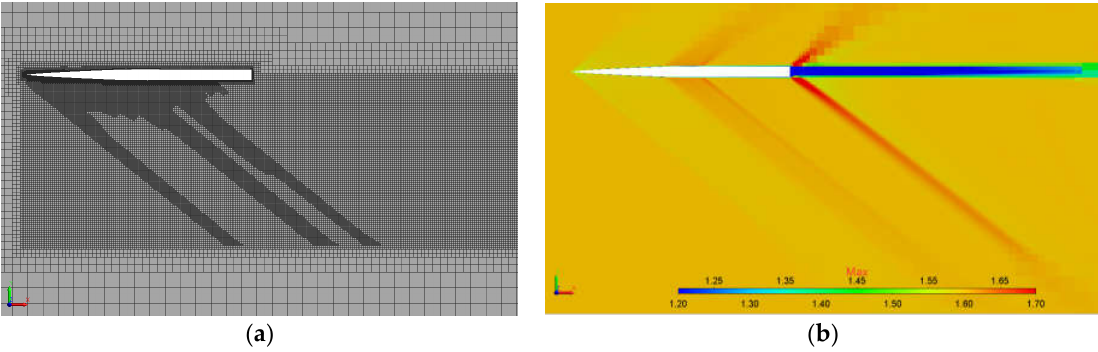
Figure 14. ( a )The first-level adaptive grid ( b ) Mach number field. Figure 14. ( a ) The first-level adaptive grid ( b ) Mach number field. Then, simulations on grids of the second and third levels of adaptation were per- formed. Figure 15 shows the solution obtained and the third-level adaptive grid.